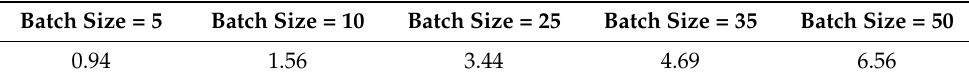
Table 4. Size (KB) of verification key, where the input arithmetic circuit is generated by Algorithm 4 Build ZK-Rollup